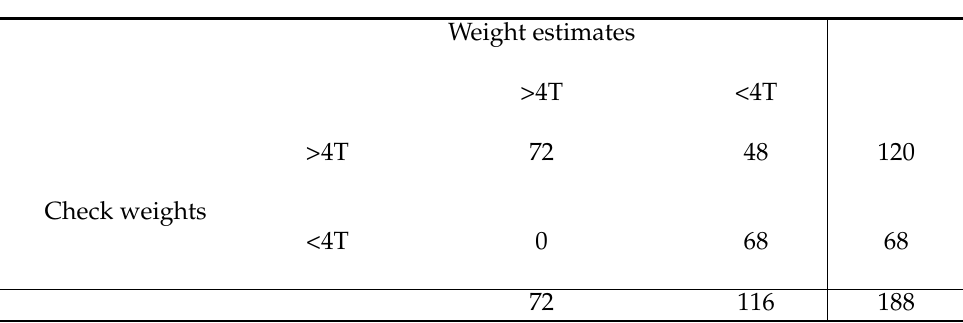
Table 7. Confusion matrix for